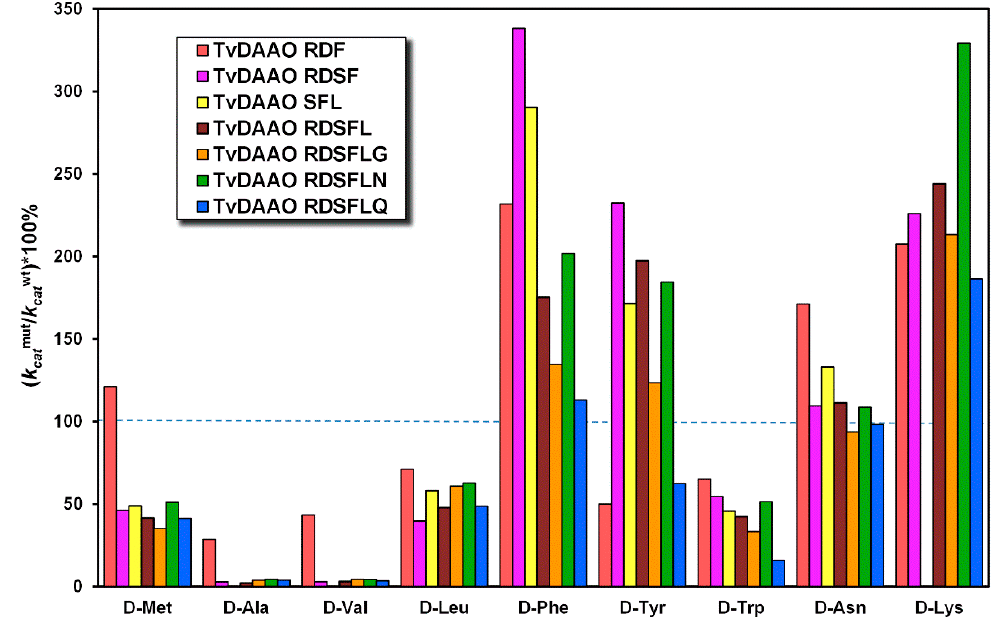
Figure 5. Relative change in catalytic constants (( k cat mut / k cat wt )*100%) of TvDAAO mutants. The catalytic constant of the wild-type enzyme was taken as 100% and indicated by the blue dashed line (0.05 M potassium phosphate buffer pH 8.0, 30 °C, air saturated).